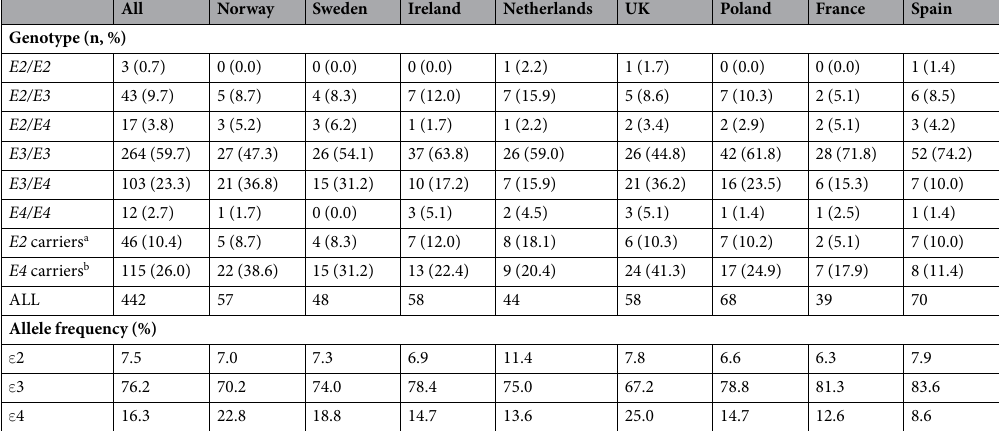
Table 1. Frequency of APOE genotype by LIPGENE Dietary Fatty Acid Intervention Study center (n = 442). Values are n (%). a Genotype groups combined; E2 carriers represent E2/E2 and E2/E3. b Genotype groups combined; E4 carriers represent E4/3 and